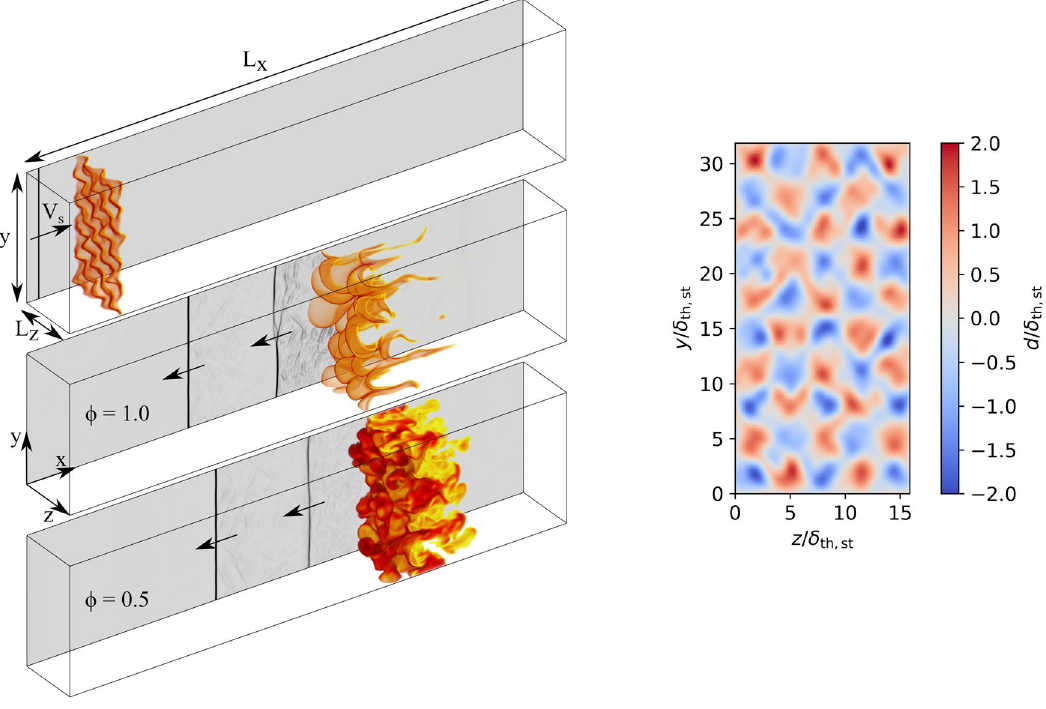
0 a planar shock wave is initialized with the 1.0 ). At t Figure 2. Left: Simulation setup (exemplary for φ = = velocity V s and propagates in positive x-direction towards the perturbed flame (top). Flame wrinkling after S 1.0 (middle) and φ 0.5 (bottom) at t reshock interactions for φ L,st /δ th,st = 0.6 . Flame is shown as = = × 0.15 /dark red and c 0.85 /bright yellow). Grayscale slice semitransparent iso-volume of varying opacity ( c ≥ ≤ of the pressure gradient magnitude (indicating the shock position) shown in background. Right: Normalized quasi-stochastic initial flame distortion in